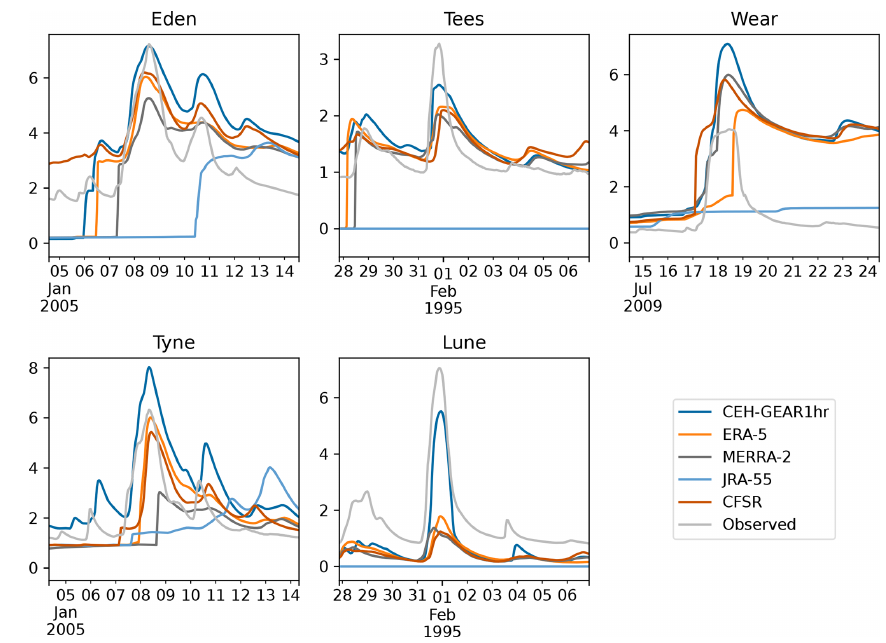
Figure 7. Stage hydrographs comparing water depths (m) from model results and observed values at each gauge.